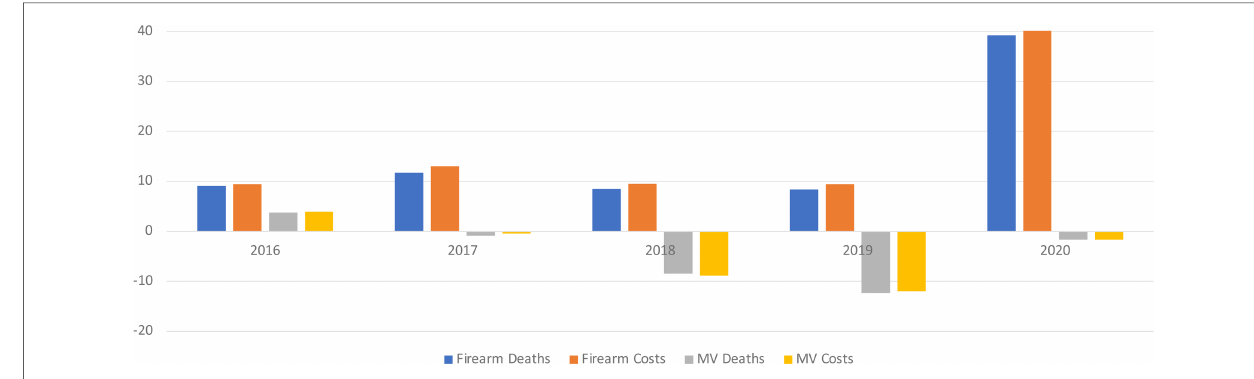
FIGURE 1 Percentage change in deaths and costs for fi rearm and motor vehicle fatalities in 1 – 24 years of age (compared to